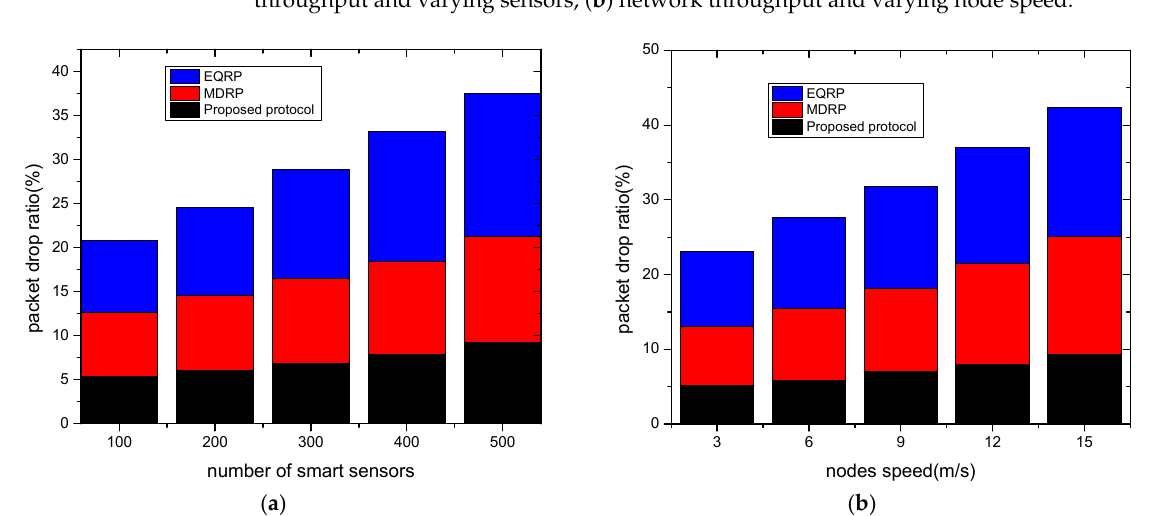
Figure 5. Varying smart sensors and nodes speed in terms of packet drop ratio. ( a ) Packet drop ratio and varying sensors; ( b ) packet drop ratio and varying node speed.